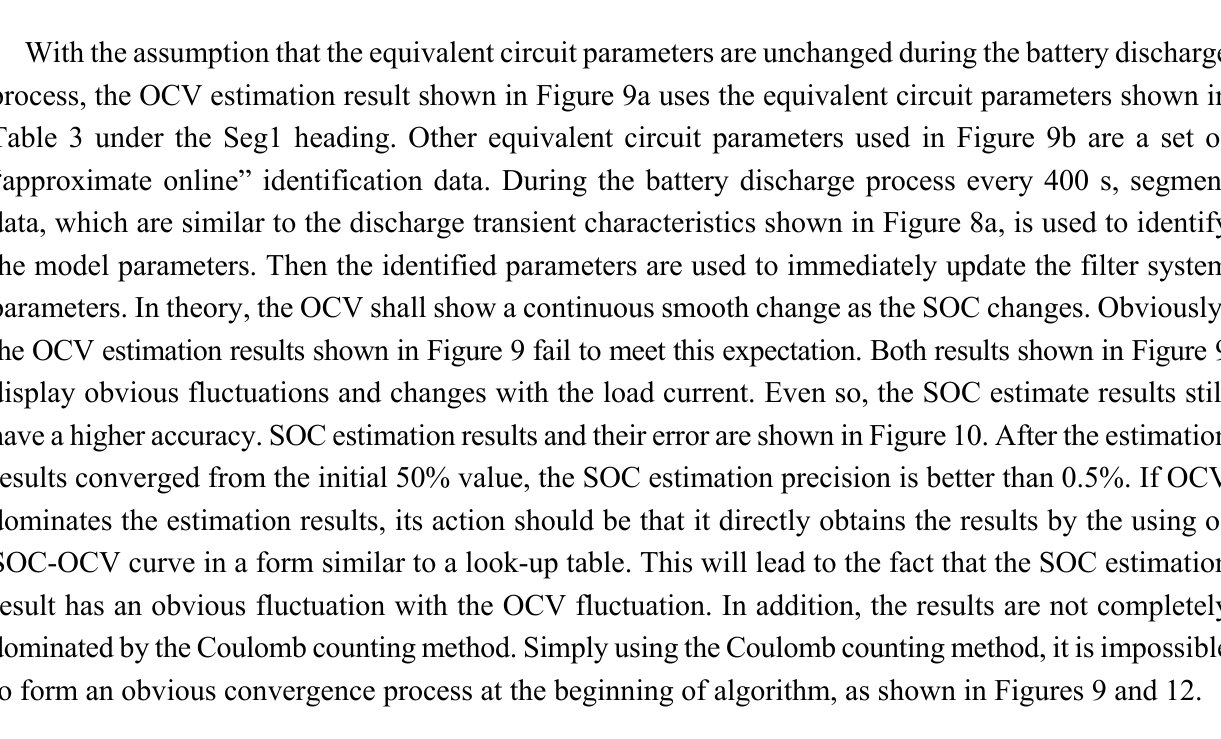
Figure 10. SOC estimation results and its error: ( a ) SOC estimation results; ( b ) SOC estimation